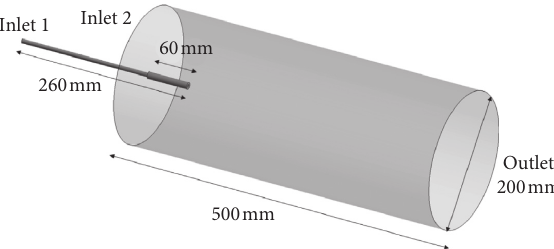
Figure 2: Computational domain of the submerged jet.